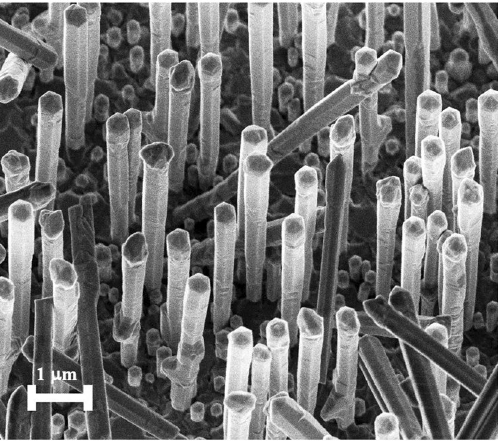
Figure 1. Characteristic SEM image of as-grown GaAs/GaNAs/GaAs CSS NW